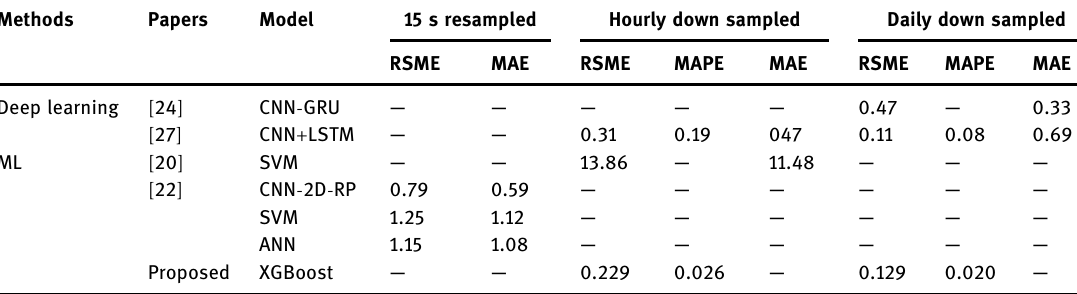
Table 3: Comparative analysis of our method with state of the art ( DL and ML techniques ) for hourly data resolution Methods